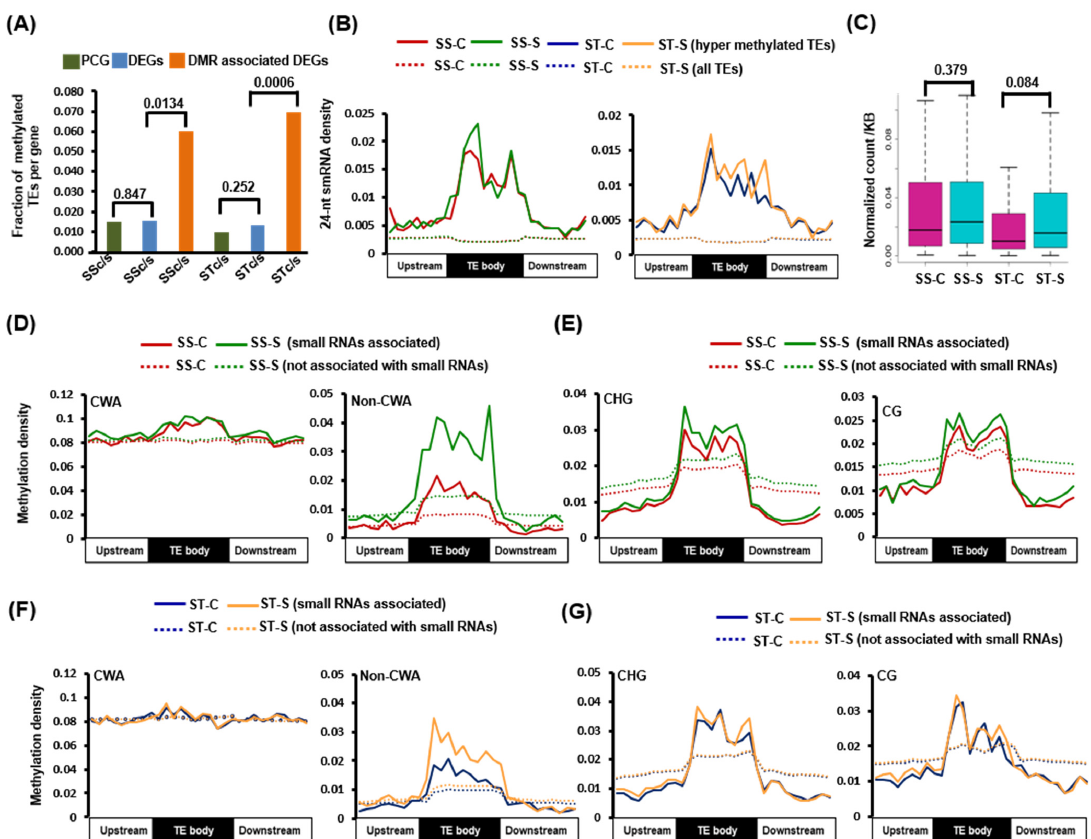
Figure 4. Influence of small RNAs on TE methylation. ( A ) Frequency of TEs within protein-coding genes, differentially expressed genes (DEGs), and dmDEGs, numbers on top represent significance value calculated by fisher exact test. ( B ) 24-nt small RNA density in CHH-hypermethylated TEs and all TEs in control (SS-C, ST-C) and stress (SS-S, ST-S) samples of both genotypes. ( C ) Normalized count of smRNAs associated with hypermethylated TEs in CHH context per kb of TE in SS-C, ST-C, SS-S, and ST-S samples (significance is calculated by Wilcoxon test). ( D – G ) Methylation density of CHH hypermethylated TEs in CWA-CHH sub-context and non-CWA-CHH sub-context that are associated and not associated with 24-nt smRNAs in SSc/s ( D ) and STc/s ( F ). ( E , G ) CHG and CG context methylation density of CHH hypermethylated TEs that are associated and not associated with 24-nt smRNAs in ( E ) SSc/s and ( G ) STc/s. the distribution of smRNAs and methylation density in the TEs and their 2 kb flanking regions. The small RNA sequencing followed by size distribution analysis of the identified